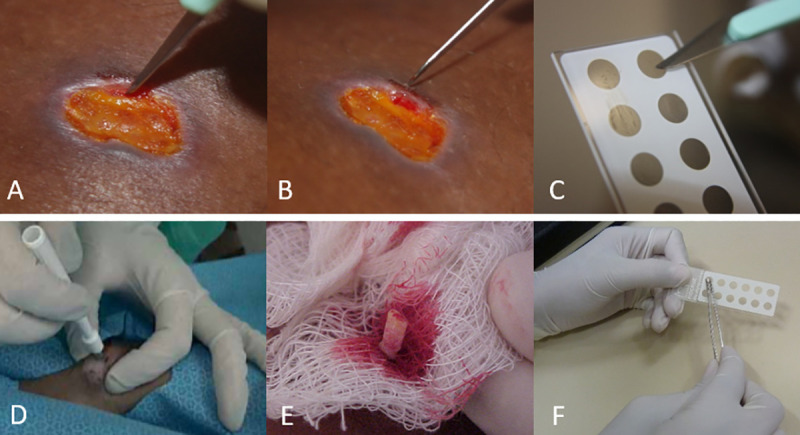
Sampling of clinical specimens from patients with cutaneous leishmaniasis.A: Scraping of the inner edge of the lesion with the aid of scalpel; B: Scraping of the outer edge of the lesion with the aid of scalpel C: Distension of the material in a microscopy slide with delimited areas; D: Biopsy with 5mm punch; E: Removal of excess blood from the fragment tissue; F: Imprint prepared with fragment tissue on the slide. Source: Clinical Research and Surveillance Laboratory for Leishmaniasis.